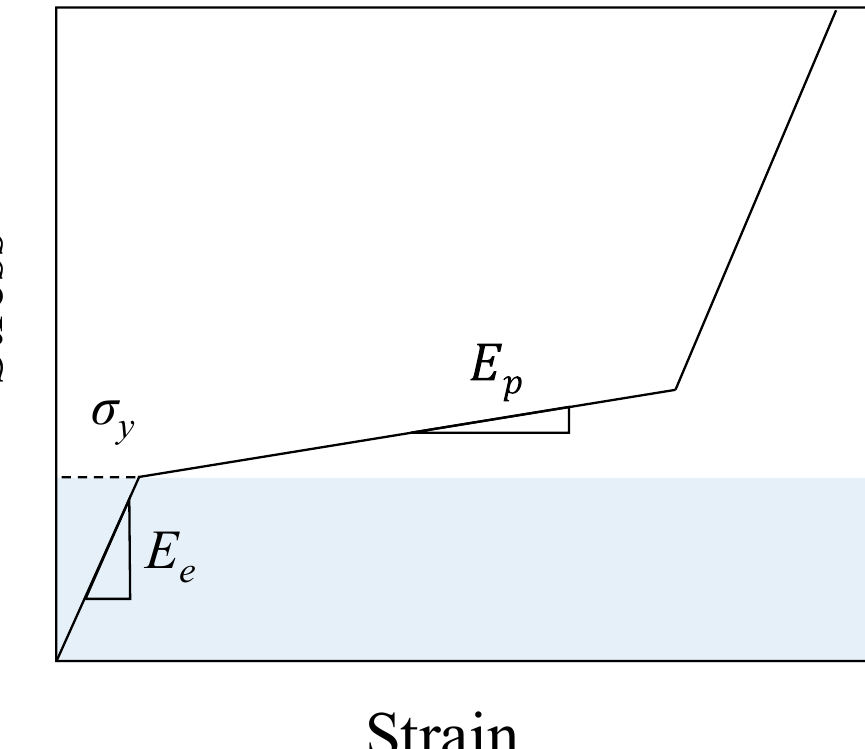
Figure 17. Simple stress–strain relationship of a typical cell structure. When the compression velocity is sufficiently higher than the plastic stress wave speed, the impact surface catches up with the wavefront of the plastic stress wave over time, and a clear discontinuity surface is generated (Figure 18). Therefore, when the compression velocity is sufficiently higher than the plastic stress wave speed that causes deformation, a discontinuity surface is formed due to the accumulation of plastic stress waves as deformation progresses, and nonuniform deformation occurs from the impact end.